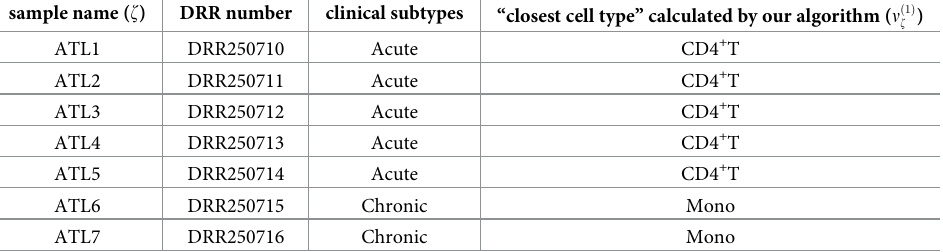
Table 5. Classification of ATAC-seq data of ATL samples. Clinical subtypes of ATL samples and “closest cell type” computed by our